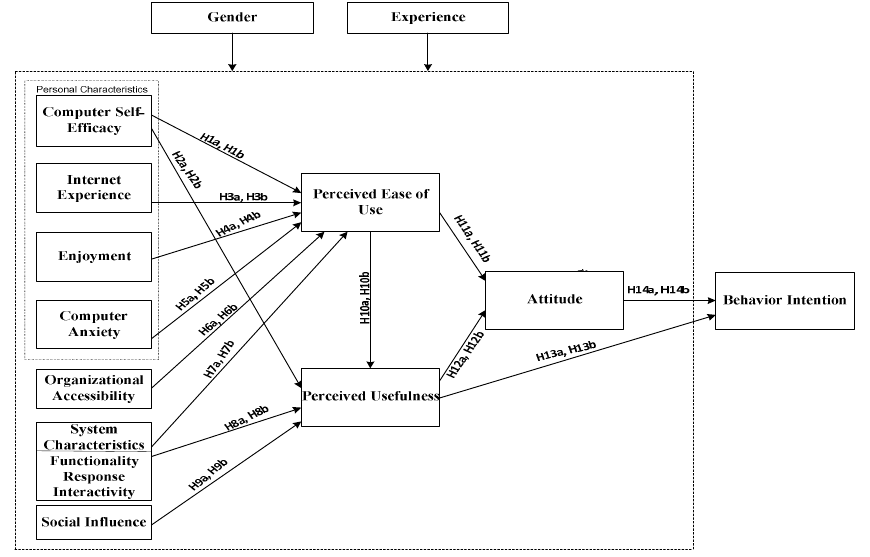
FIG. 1. CONCEPTUAL RESEARCH